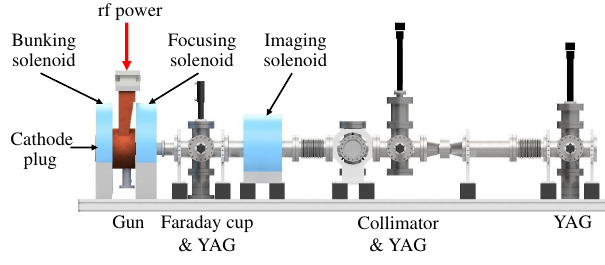
FIG. 4. Layout of the ACT beam line at